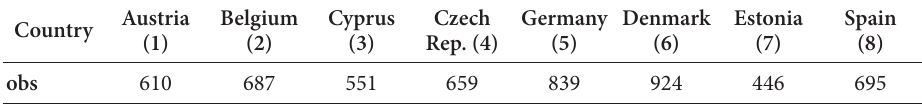
Table 2. Number of observations and average for overskilling and underskilling for each